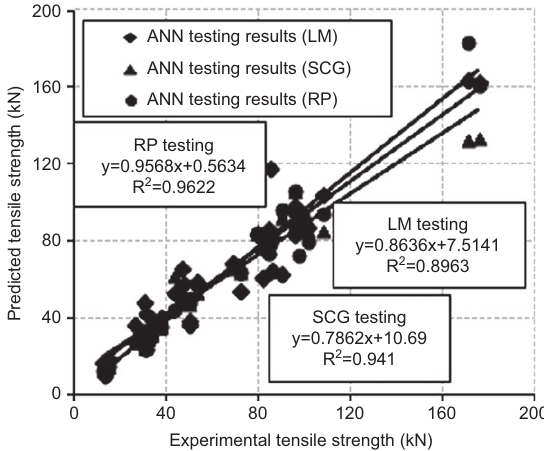
Figure 6 ANN (SCG, LM, and RP algorithms) results for single anchors.